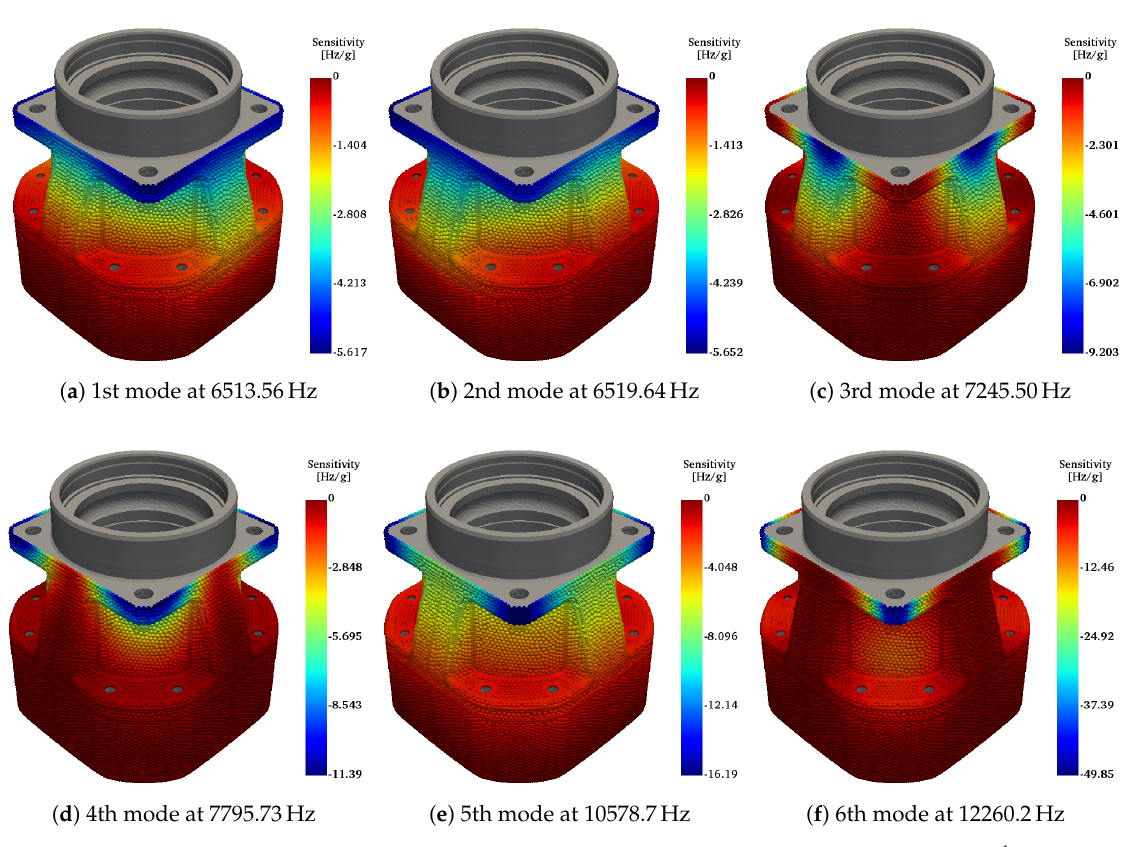
Figure 10. Sensitivities of the eigenfrequencies of the gear housing with respect to added mass